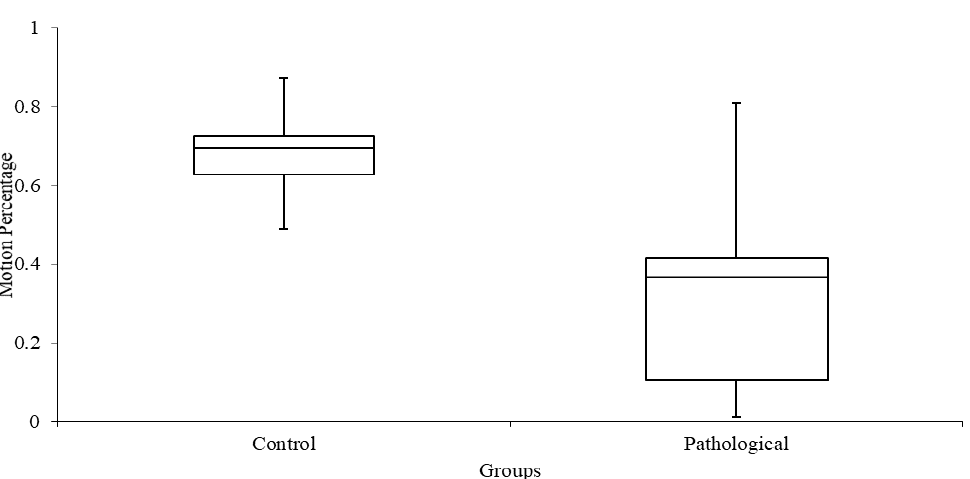
Figure 5 . Comparison of motion percentage distribution for control and pathological groups (showing median, 1 st and 3 rd quartiles, and upper/lower